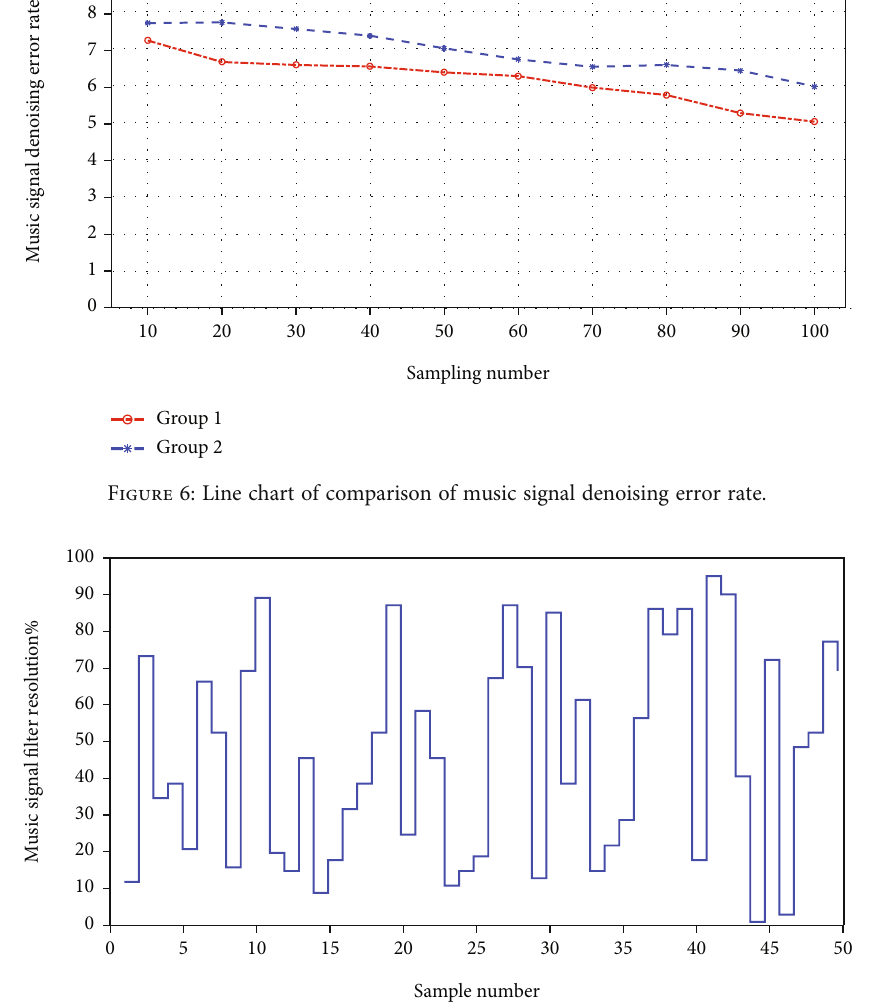
Figure 7: The fi lter resolution ladder diagram of the music